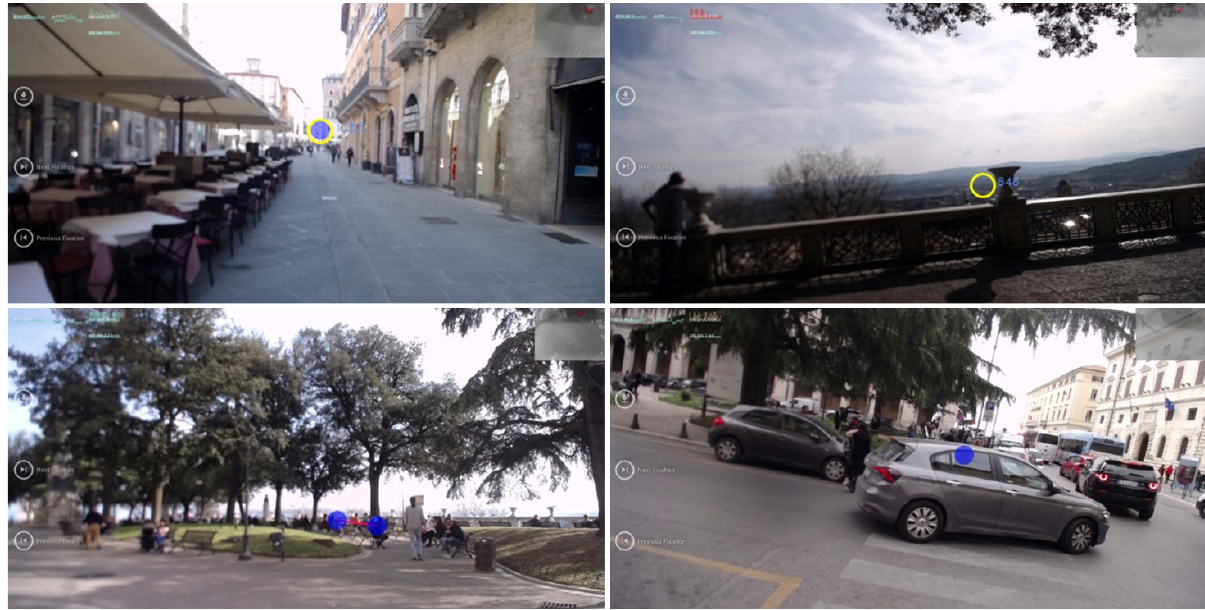
Figure 8 - Gazes and